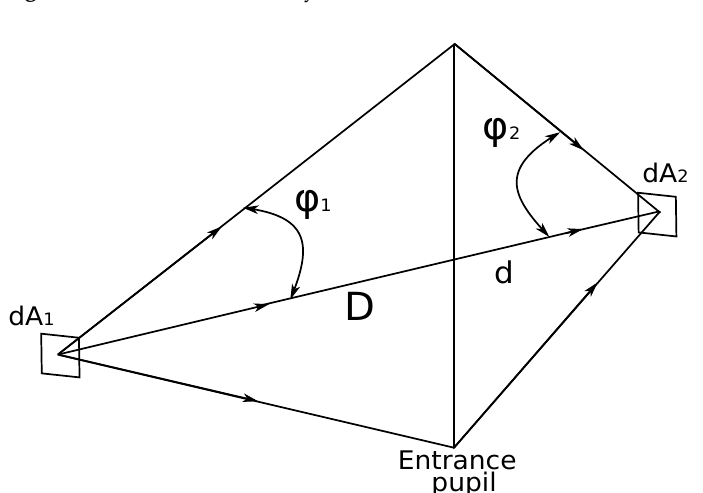
Figure 4. FOV in a sensor array Figure 3. FOV in a sensor array